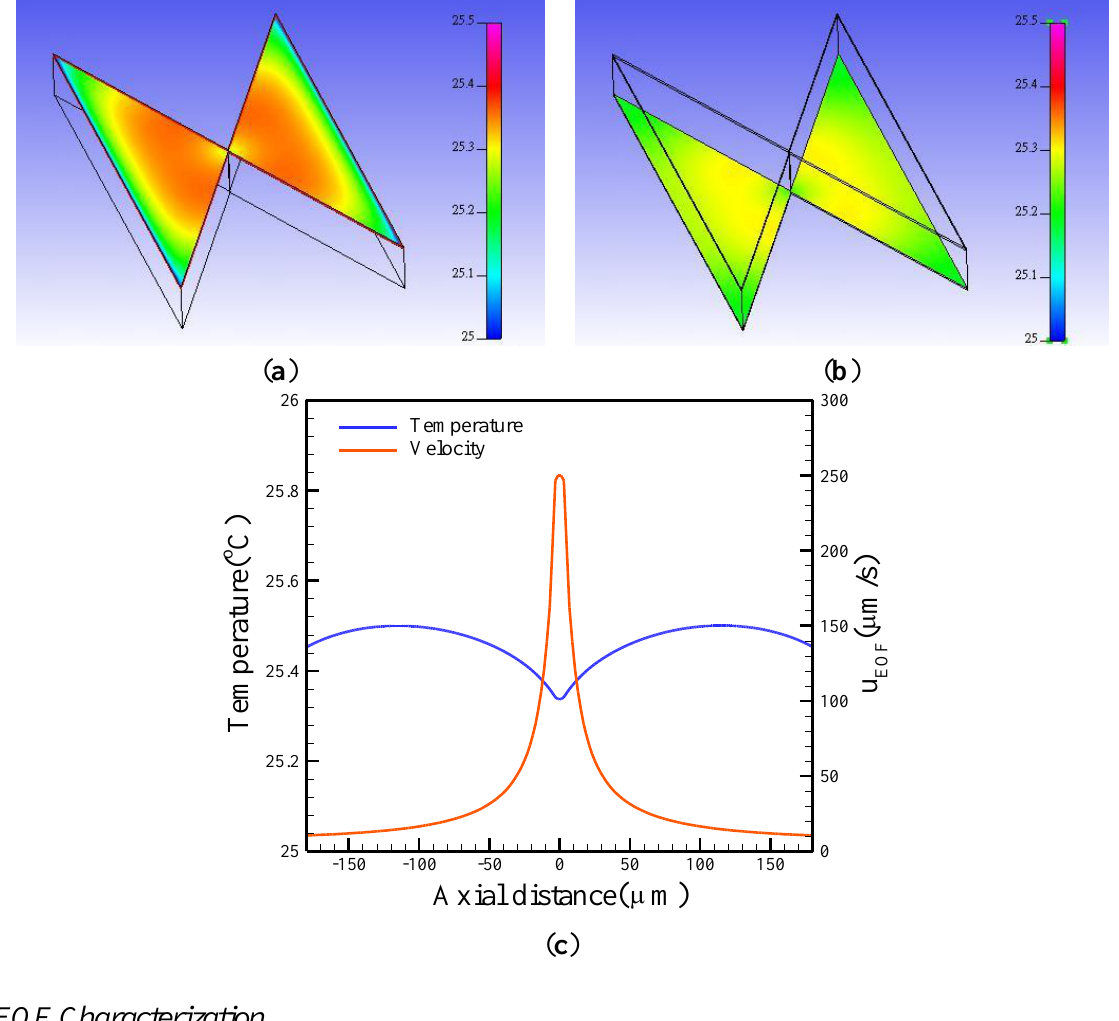
Figure 5. Numerical calculations of the ( a ) top and ( b ) bottom temperature contours of insulators and ( c ) the central x-axial temperature, as well as velocity profiles at the applied potential V=90 V ·cm −1 and the frequency f = 1 pp